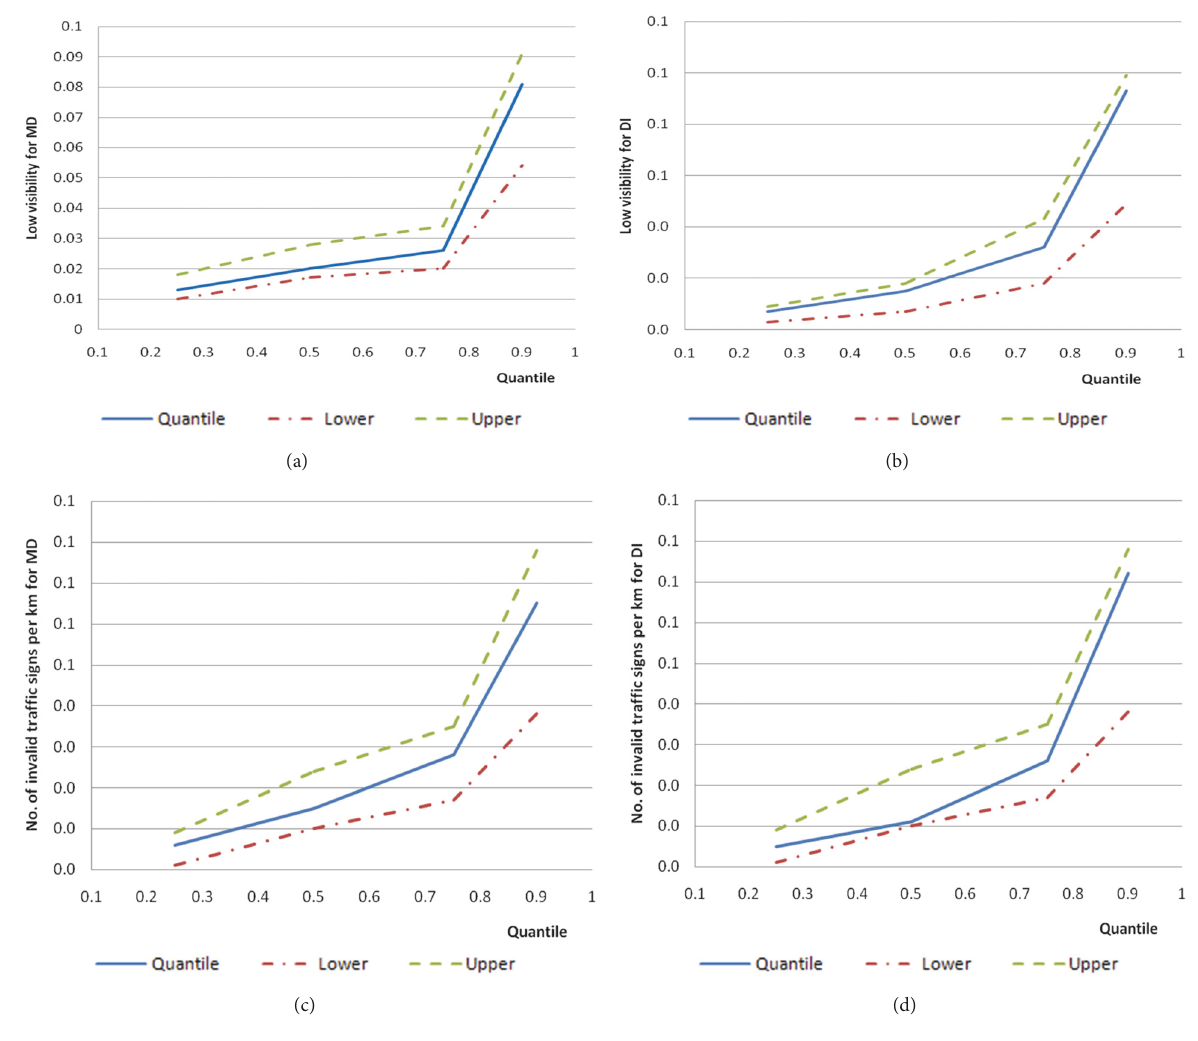
Figure 3: Quantile plots for variable